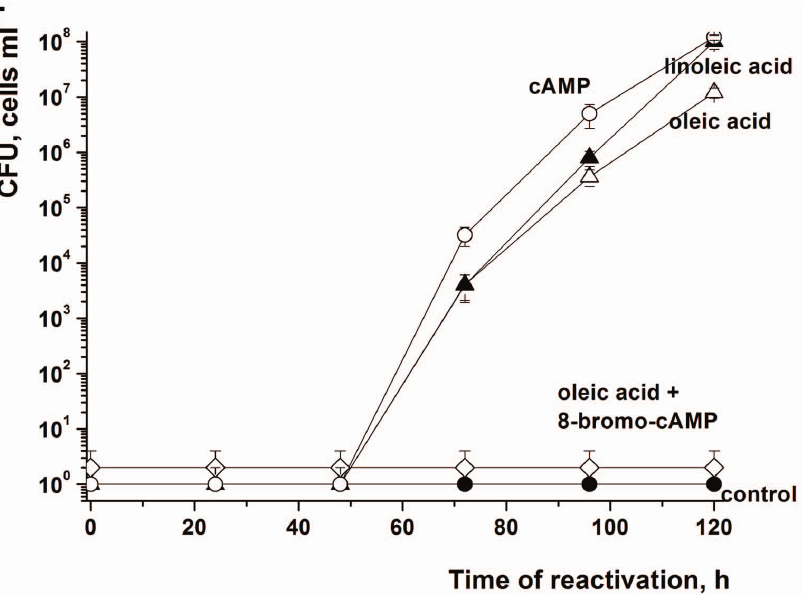
Figure 3. cAMP stimulates the resuscitation of M.smegmatis NC cells. NC cells were obtained and resuscitated in batch format. The OD 600 was measured after 5 d of resuscitation. The concentrations of oleic acid, linoleic acid, cAMP and 8-bromo-cAMP were 2 m M, 1.7 m M, 3 mM and 2 mM, respectively. This experiment was repeated three times with similar results; the error bars represent the standard error of the mean. doi:10.1371/journal.pone.0082914.g003 PLOS ONE |